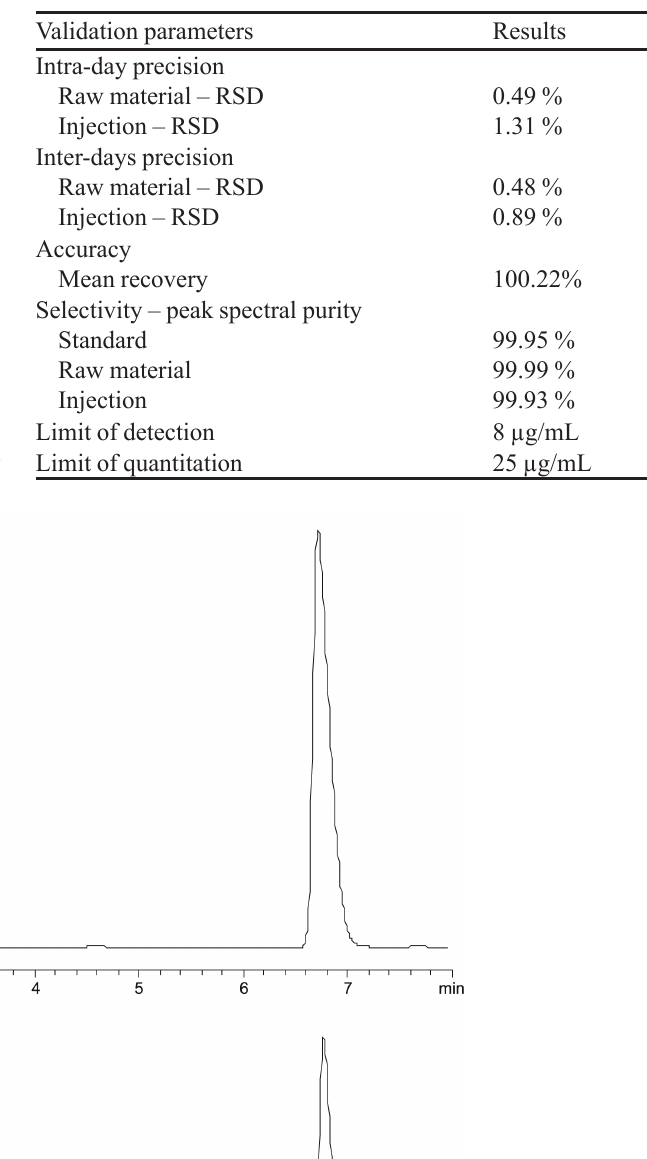
TABLE II – Results of the validation process of the HPLC method